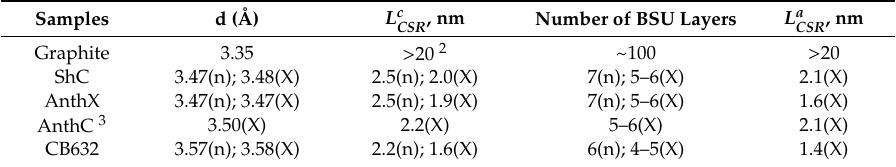
Table 1. Structural parameters of amorphous carbons [47] 1 .